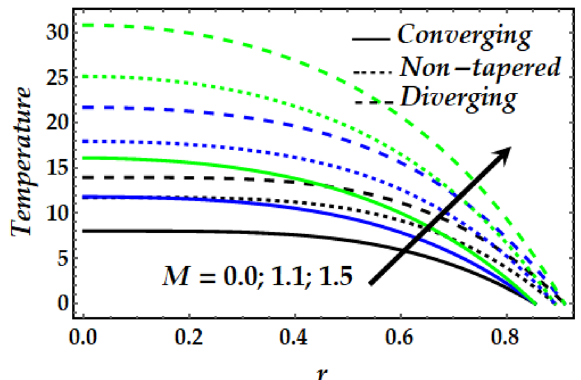
Figure 12. Temperature profile against distinct values of M .